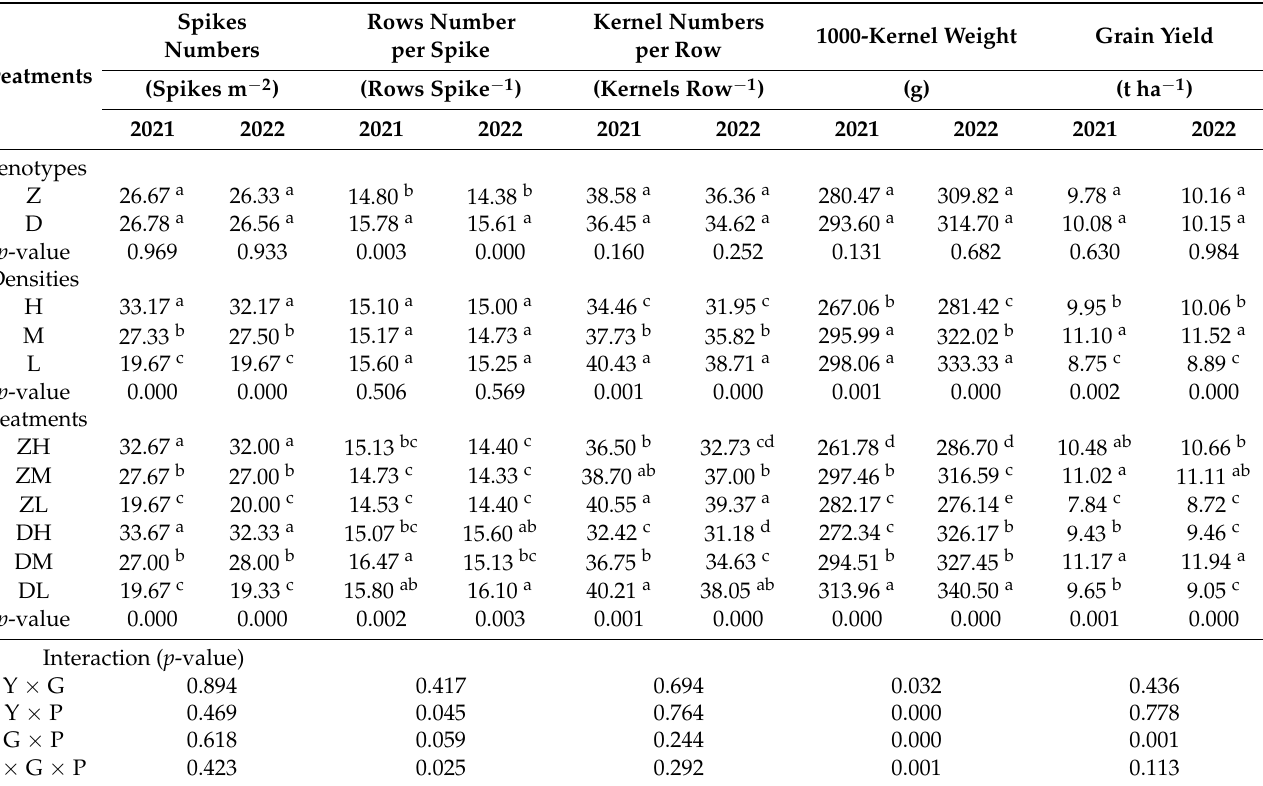
Table 2. Effects of planting density and genotypes on grain yield and yield components in 2021 and 2022 summer maize growing